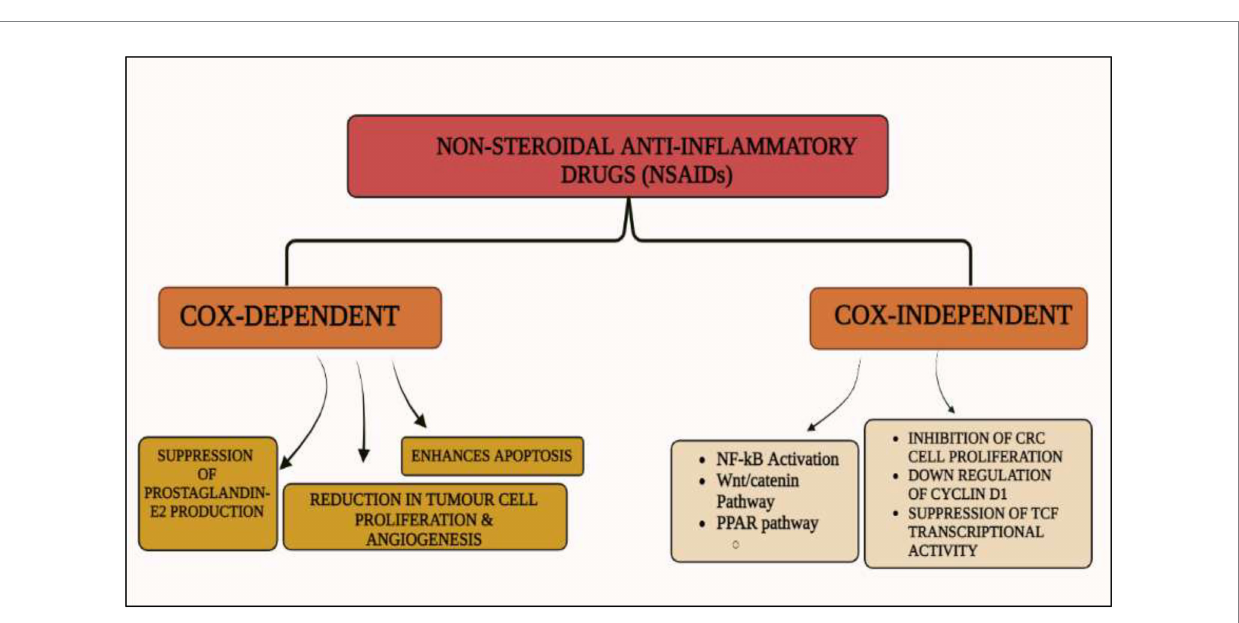
FIGURE 2 Cox-dependent and independent mechanism overview associated with NSAIDs. Cyclooxygenase dependent and independent pathways play a significant role in anti-tumorigenesis. The major anticancer action of NSAIDs is thought to be COX 2 suppression mediated decrease of prostaglandin E2 synthesis, which inhibits tumor cell proliferation and angiogenesis while increasing